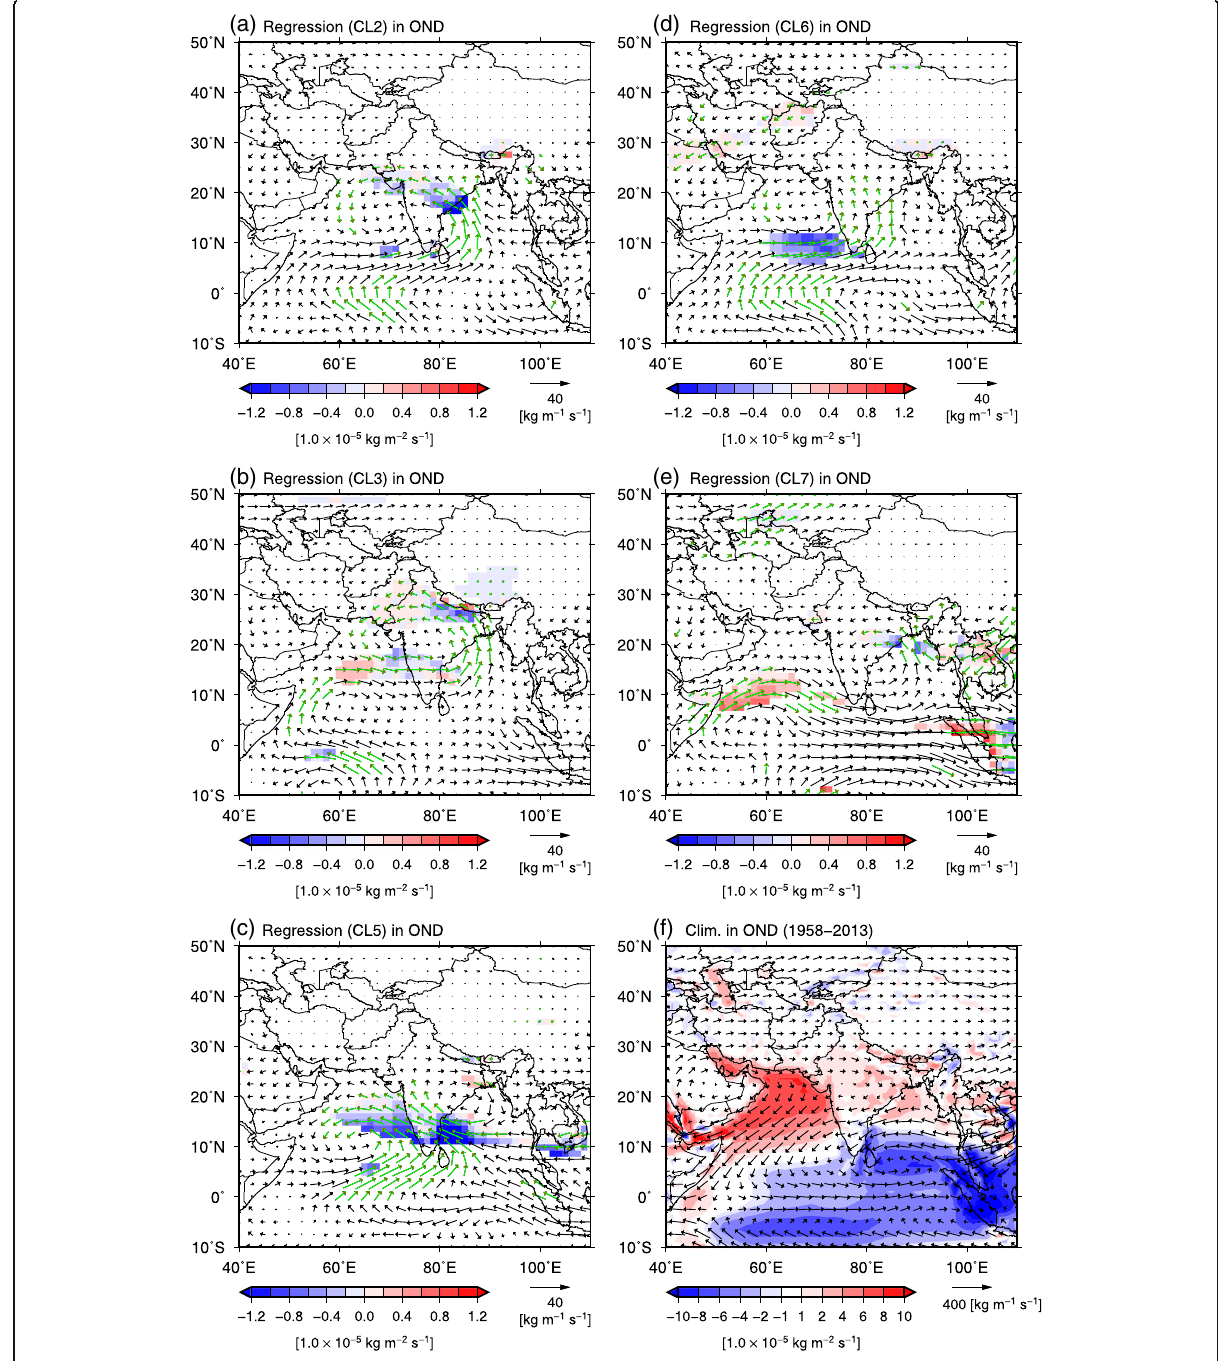
Fig. 10 Same as Fig. 8 but for the post-monsoon season (OND) The regression coefficient (objective variable is precipitation) between interannual variation of rainfall and water vapor flux (kg m − 1 s − 1 ) (vector) and its divergence (× 10 − 5 kg m − 1 s − 1 ) (shaded) as the regression coefficient (objective variable is precipitation) for each cluster ( a ) – ( e ), and the distribution of climatological averaged values for 1958 – 2013 for the water vapor flux and divergence ( f